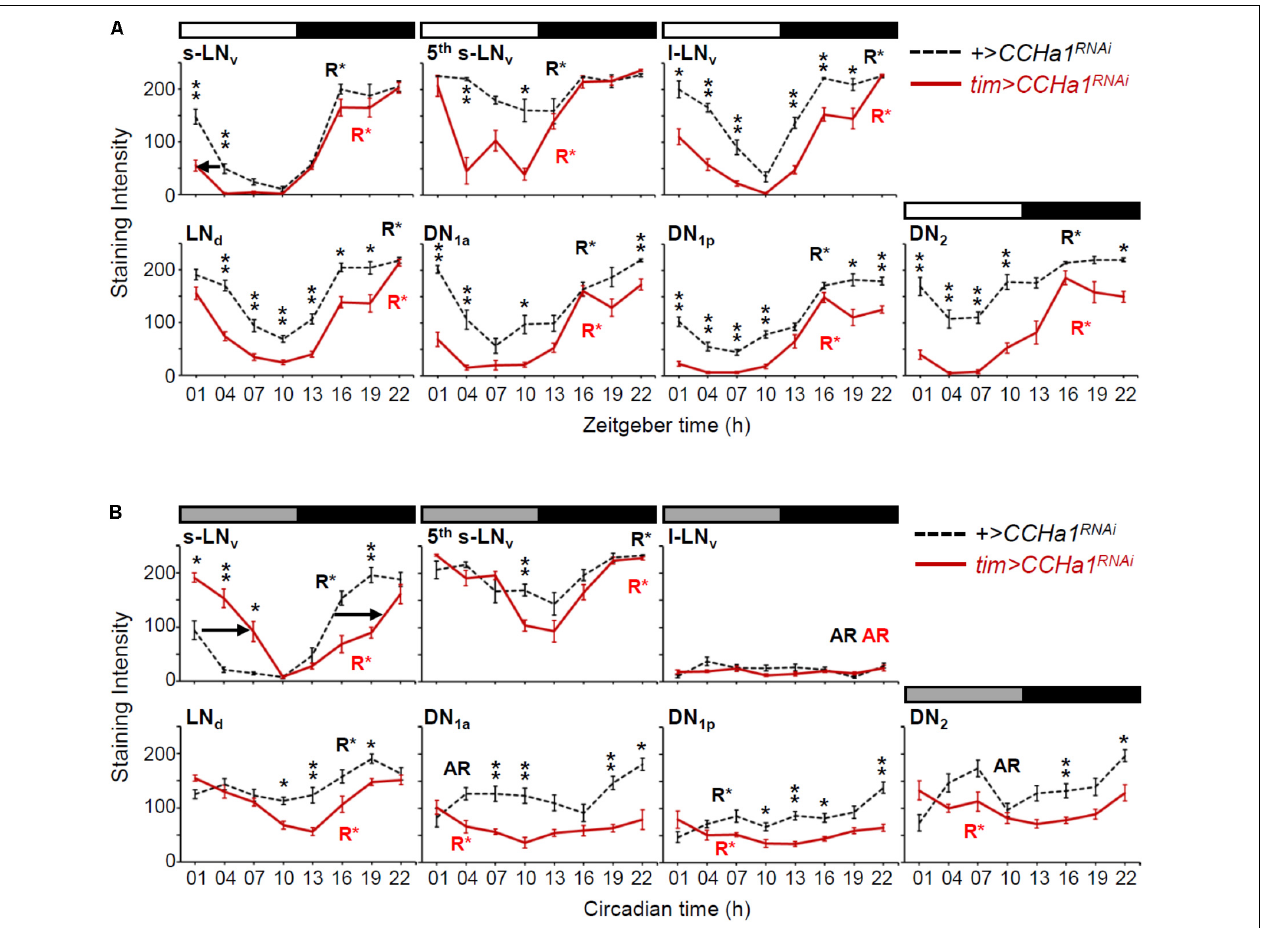
FIGURE 7 | Cyclic expression of the PDP1 clock protein in the CCHa1 knockdown flies. The PDP1 levels (mean ± SEM) in clock neurons were measured at 3-h intervals during LD (A) and DD (B) . Circadian time in DD does not indicate the exact subjective time but simply indicates the original zeitgeber time. Hemispheres of 9 different brains were analyzed for each time point. Dashed and colored solid lines indicate the data of the control ( UAS-dicer2;+/UAS-CCHa1 RNAi ) and the RNAi ( UAS-dicer2;tim-Gal4/UAS-CCHa1 RNAi ) strains, respectively. The rhythmicity of PDP1 expression is indicated by R ∗ (rhythmic) or AR (arrhythmic), analyzed by CircWave ( p < 0.01). (A) The decrease in PDP1 levels in the morning was slightly phase-advanced in the s-LN v neurons (arrow). (B) The PDP1 cycling in the RNAi flies was significantly phase-delayed in the s-LN v neurons compared with that of the control flies (arrows). We performed Mann–Whitney U test followed by Bonferroni correction to examine the effect of CCHa1 knockdown for each time point ( ∗ p < 0.05, ∗∗ p <